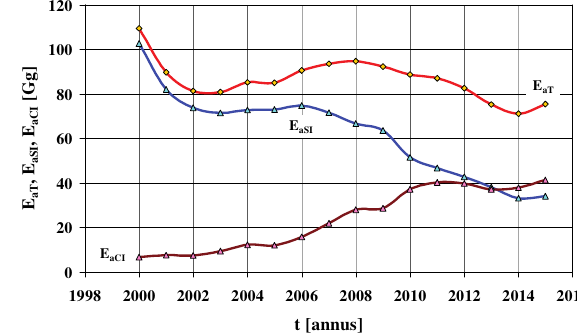
Fig. 5. National annual emission of carbon monoxide from passenger cars